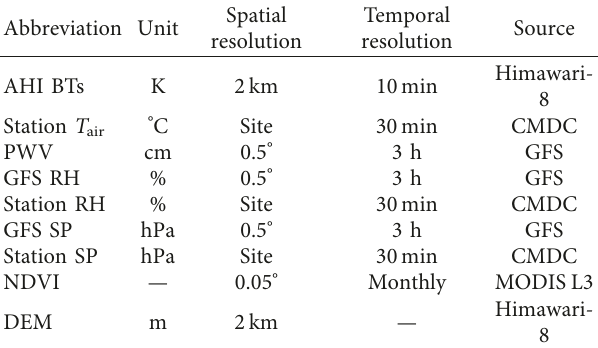
Table 2: Characteristics of the primary data used in this